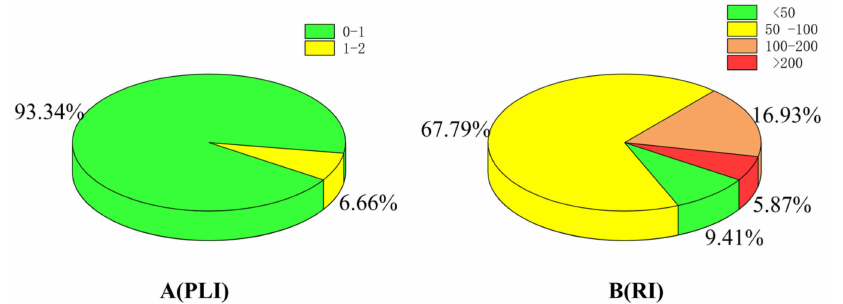
Figure 7. Percentage of areas with different grades of the soil pollution load index ( A ) and potential ecological risk index ( B ). The grading standards of PLI are as follows: Level 1 (green) pollution-free (PLI < 1); Level 2 (yellow) moderate pollution (1 < PLI < 2). The grading standards of RI are Level 1 (green) slight potential ecological risk (RI < 50); Level 2 (yellow) medium potential ecological risk (50 < RI < 100); Level 3 (orange) relatively high potential ecological risk (100 < RI < 200); and Level 4 (red) high potential ecological risk (RI >